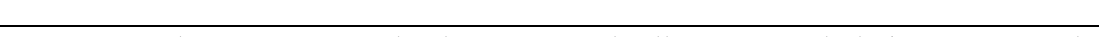
Fig. 3 LCL161 creates and immunosupportive TME by polarizing TAM toward M1-like. a – c Expression levels of immune-promoting chemokines a and cytokines b and immunosuppressive cytokines c within the interstitial fl uid of 12-day-old EMT6 tumors, measured by Luminex (duplicate experiments; mean ± SD; ANOVA with Tukey ’ s multiple comparisons test). d mRNA expression of type I interferon ( IFN ) and IFN-stimulated genes in EMT6 tumors 7 days after LCL161 treatment initiation, measured by qPCR (single experiment; mean ± SD; ANOVA with Tukey ’ s multiple comparisons test). e Intracellular staining for arginase-1 in CD11b + MHC-II ± Ly6C ± TAMs isolated from EMT6 tumors 72 h post treatment (duplicate experiments; mean ± SD; t -test). f Immune-promoting cytokines measured in BMDM cell culture media 12 h after LCL161 treatment ± VSV Δ M51 treatment (MOI 10, added at 6 h), measured by Luminex ( n = 3 biological replicates, single experiment; mean ± SD; ANOVA with Tukey ’ s multiple comparisons test). g Extracellular H 2 O 2 production in BMDMs following phagocytosis of serum-opsonized zymosan particles, measured by oxidation of the Amplex UltraRed reagent ( n = 3 biological replicates per experiment, duplicate experiments; mean ± SD; ANOVA with Tukey ’ s multiple comparisons test). h CD69 surface expression on transgenic OT-1 T cells co-cultured with BMDM pulsed with full-length OVA, measured by fl ow cytometry ( n = 3 biological replicates per experiment, duplicate experiments; mean ± SD; ANOVA with Tukey ’ s multiple comparisons test). i CD69 surface expression on transgenic 2D2 T cells co-cultured